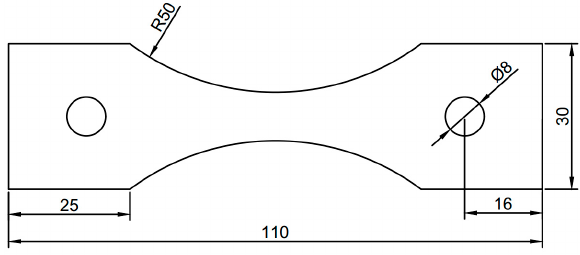
Figure 1. Pattern of specimens (units: mm).